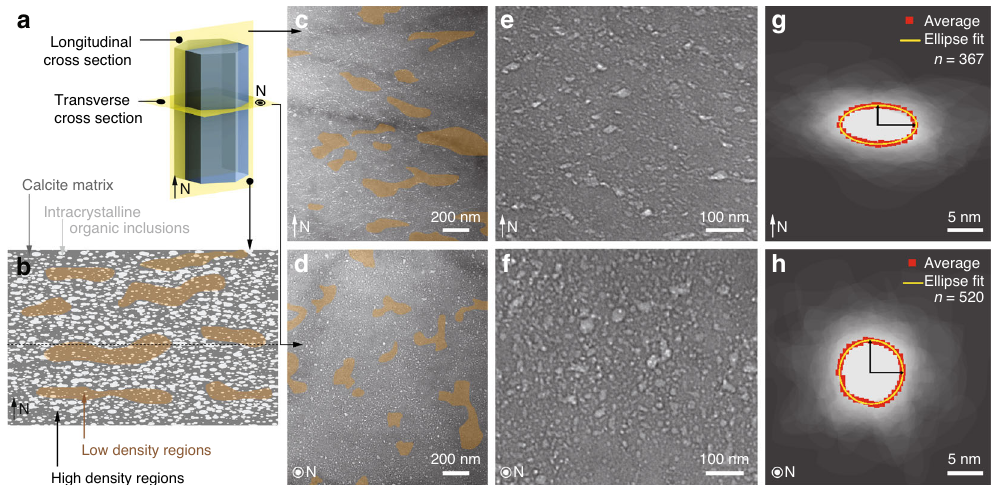
Fig. 2 Structural characterizations of the intracrystalline inclusions in the prisms of Atrina rigida . a Illustration of sample orientations (parallel and perpendicular to N) for analysis using transmission electron microscopy (TEM) . b Schematic diagram illustrating the presence and distribution of low electron density intracrystalline defects when viewed in the direction parallel to N. c , d Low-magni fi cation and e , f high-magni fi cation TEM images of the biogenic calcite, revealing regions of high and low density of defects (highlight with brown shaded areas) in two orientations: c , e parallel to and d , f perpendicular to the normal direction. g , h Images of overlaid contours of individual intracrystalline defects in two orientations: g parallel to and h perpendicular to the normal direction. The red dotted and yellow solid lines are the average and fi tted pro fi les,